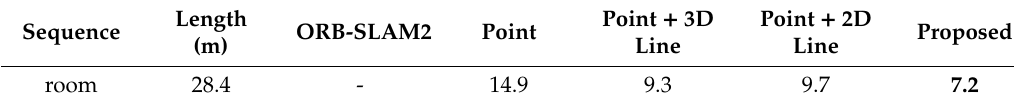
Table 2. Comparison of ATE RMSE (cm) on room